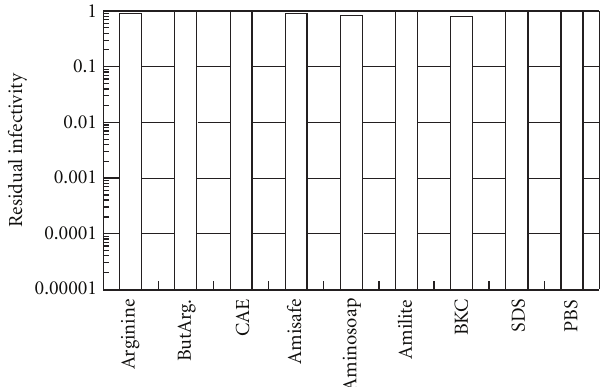
Figure 3: Inactivation of poliovirus. See the legend to Figure 1.